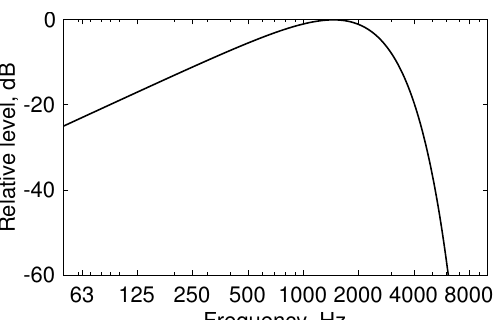
Figure 11. Frequency characteristics of the modulated Gaussian pulse. Figure 12a,c presents the comparisons of the CPU times on sequential calculation of the PW-FEMs with Mesh 1, Mesh 2 and Mesh 3 and the classical linear and quadratic FEMs, respectively, showing (a) CPU times in constructing the global stiffness and mass matrix, K and M , (b) CPU times in solving the linear system of equations, and (c) CPU times in total. The results indicate that the hotspot of computations in the PW-FEM is the global stiffness and mass matrix construction process, which occupy 96.4% in the total CPU time for Mesh 1 at 4 kHz, and it is 82.6% for Mesh 2 and 61.7% for Mesh 3. It is also noteworthy that using the finest mesh, Mesh 3, provides the fastest analysis at frequencies higher than 1.5 kHz. In contrast, the PW-FEM can quickly solve the linear system of equations with the sparse direct solver thanks to the marked reduction in the DOFs, as shown in Figure 12b. As an example, the total CPU times at 4 kHz are 191 s (Mesh 1), 44 s (Mesh 2), and 21 s (Mesh 3). In the PW-FEM used here, the element stiffness and mass matrix of Ω × q Ω e e size q must be processed by the high-order Gauss–Legendre integration, which tot tot ) numerical complexity. Since the integration point number n has an O ( n 2 g